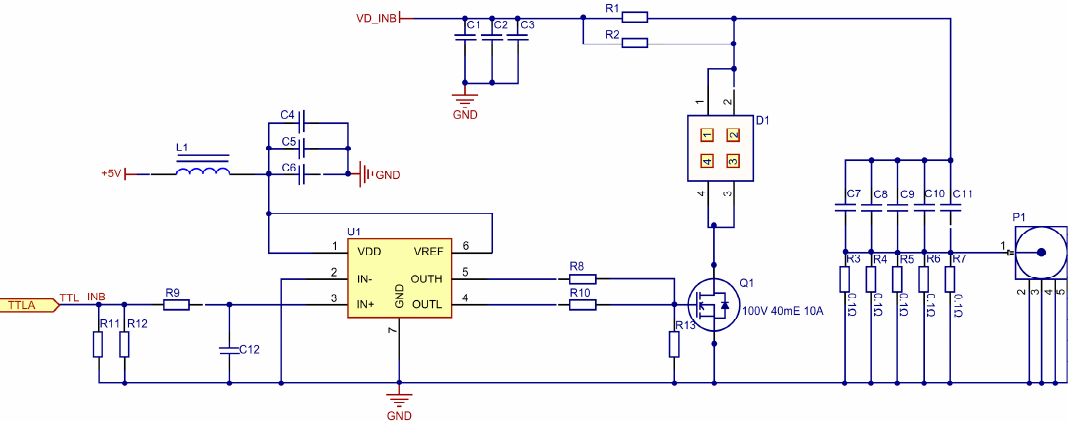
Figure 10. Peak current test circuit.